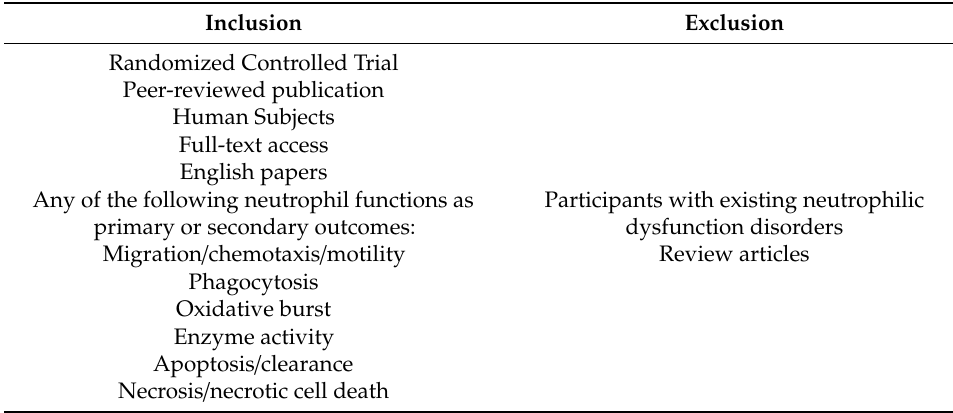
Table 1. Inclusion and exclusion